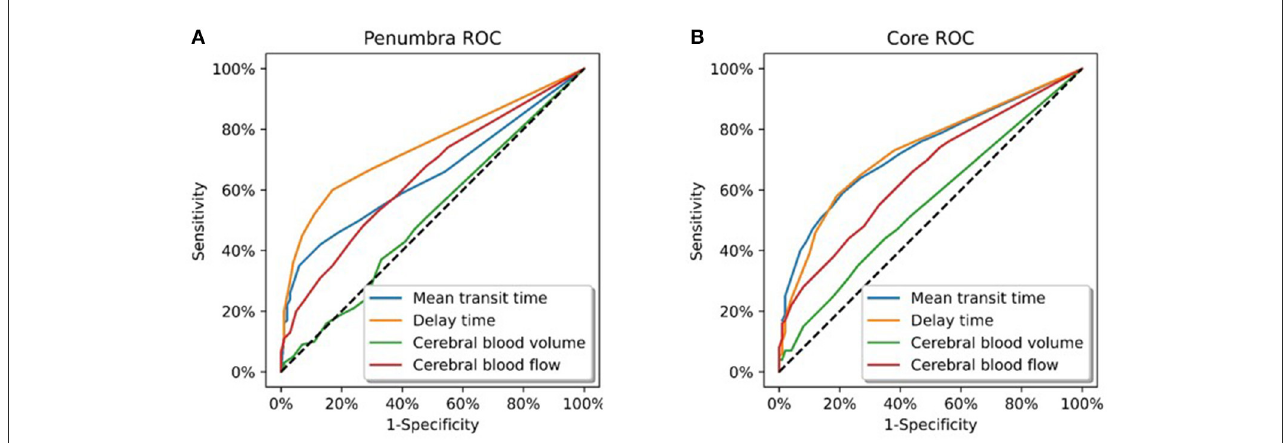
FIGURE1 Receiver operating curve analysis. (A) All patients in Group 1 (total of 6258358 voxels). These patients demonstrated a complete occlusion of a posterior circulation vessel on follow up imaging. Delay time was the CT parameter which optimally represented the ischaemic penumbra (AUC = 0.74). (B) All